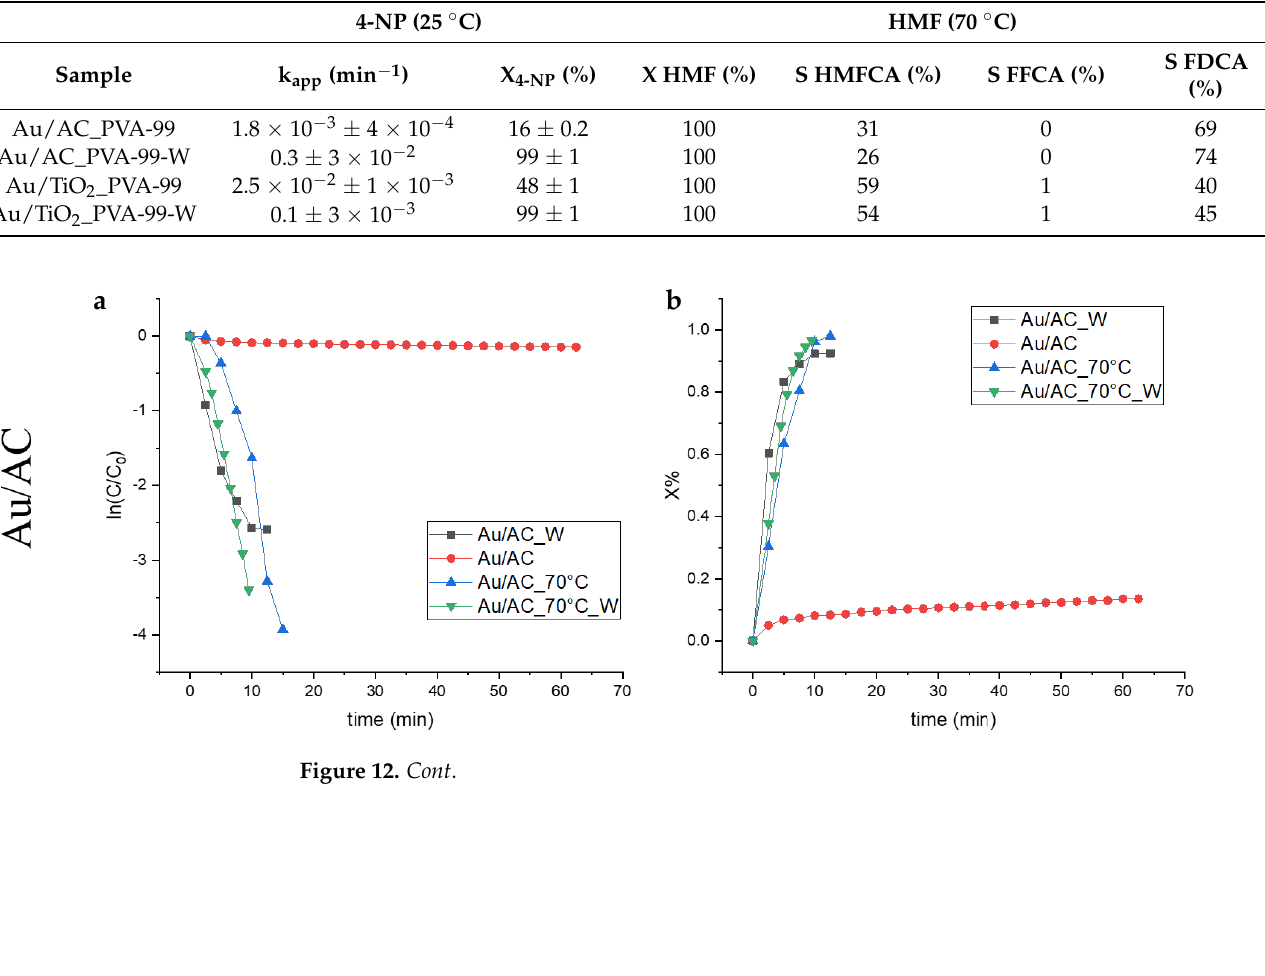
Figure 12. Kinetic performances in 4-NP reduction of the washed and unwashed catalysts supported on either active carbon ( a , b above) or titania ( c , d ) at room temperature and at 70 °C. 2.7. Characterization of the Washed Catalysts The prepared catalysts were characterized by spectroscopic (ATR-IR and XPS) and microscopy analysis (TEM) in order to rationalize the behavior observed during the cata- lytic tests. Specifically, the techniques were chosen to investigate the effect of the treat- ment with hot water on the surface of catalysts and mean Au particle size. The IR spectra of gold nanoparticles supported on titania after the washing is reported in Figure 5 and compared with the same sample untreated and titania. The O – H stretching and bending at 3300 and 1650 cm − 1 , respectively, were ascribed to the water adsorbed on the surface of the catalyst. Despite the presence of the intense band derived from water, in the nanostructured catalysts (Au/TiO 2 ), the presence of C – H stretching at 3000 cm −1 and the signal of C – H bending at 1300 cm −1 of the aliphatic polymeric chains were observed (Fig- ure 13). The disappearance of this band in the washed sample confirmed the removal of the polymer from the surface of the catalysts with the methodology proposed. In addition, the trend highlighted was further investigated by XPS analysis through the comparison of the active phase expose before and after the washing phase (Table 3, Figure S1). As expected, the typical XPS spectrum related to the gold metallic state could be observed in the two peaks at 84 eV and 87.5 eV attributed to the Au 4f 7/2 and Au 4f 5/2 spin-orbital cou- pling, respectively. However, in the case of catalysts supported on titania a shift of Au 4f binding, energy was observed due to the dominant presence of Au δ− (83.2 eV) on the sup- port that can interact with the superficial Ti 3+ defective sites [51 – 53]. Instead, the Ti exhibited